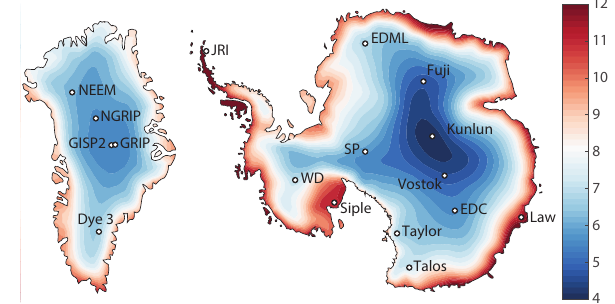
Figure 8. Synoptic-scale barometric pumping strength for Green- land and Antarctica using 6-hourly ERA-Interim reanalysis surface pressure values for the period 1 January 2010 through 31 Decem- ber 2011. The color scale gives the root mean square of the pressure rate of change d p/ d t in units of mbarday − 1 . Key ice core drilling locations are